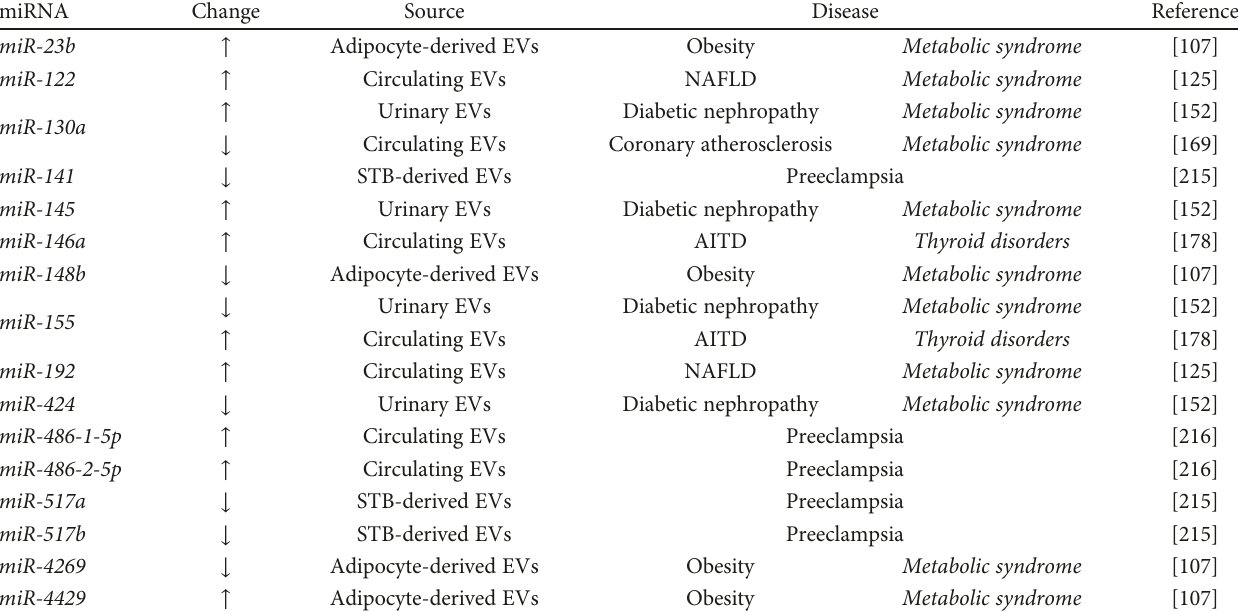
Table 2: Most relevant EV-miRNAs for biomarker application in endocrine